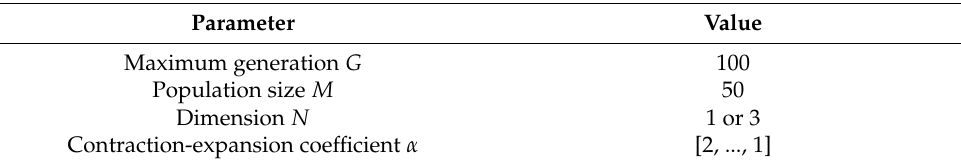
Table 6. Parameters used in QPSO algorithm.